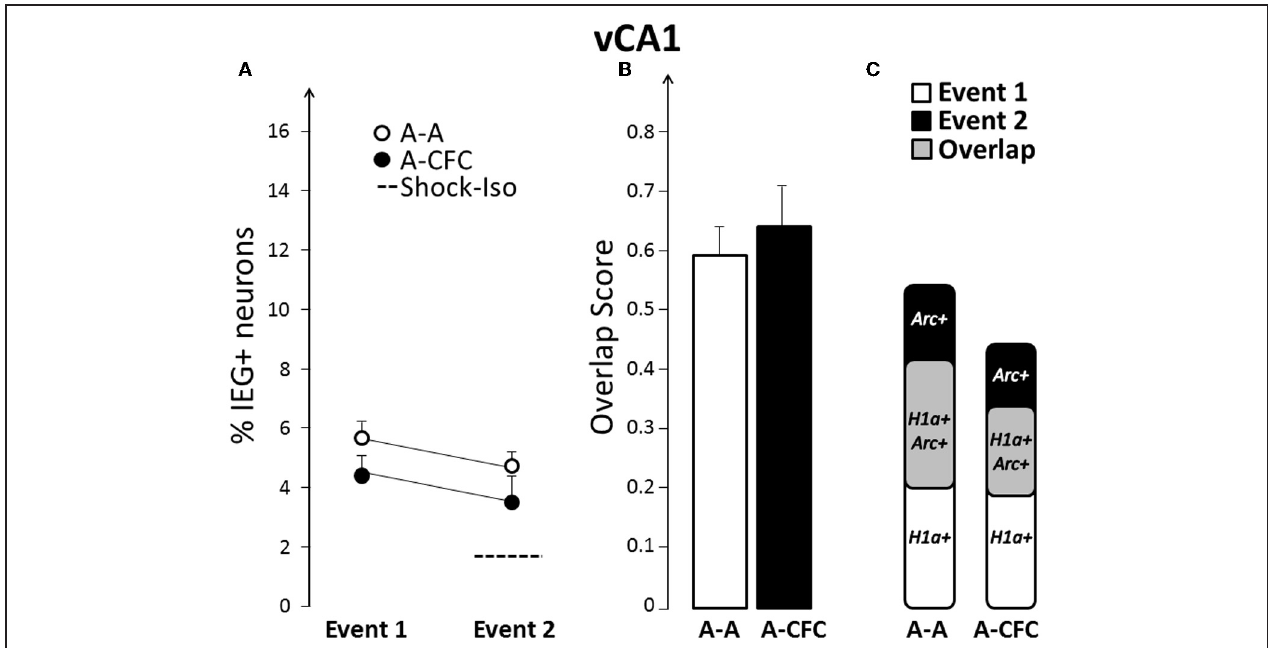
FIGURE 5 | Comparison of ensemble size and overlap between vCA1 ensembles activated during both events in A-A and A-CFC groups: (A) Size of IEG-expressing ensembles expressed as percentage of